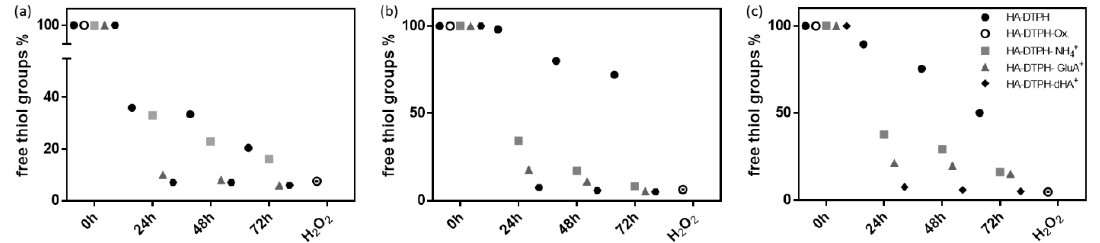
Figure 2. Free thiol group amount within hydrogel network determined by Ellman’s assay. ( a ) for HA-DTPH 29% , ( b ) HA-DTPH 42% and ( c ) HA-DTPH 58% .